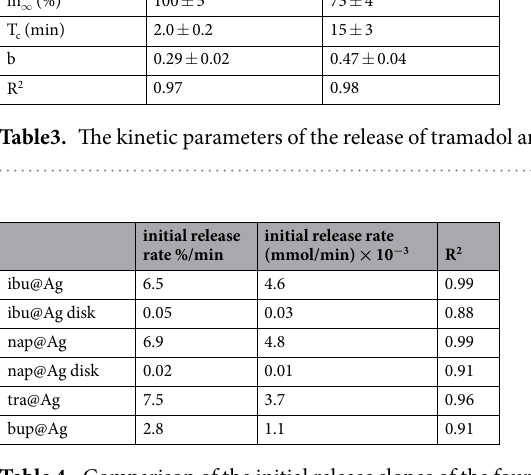
Table 4. Comparison of the initial release slopes of the four entrapped drugs.